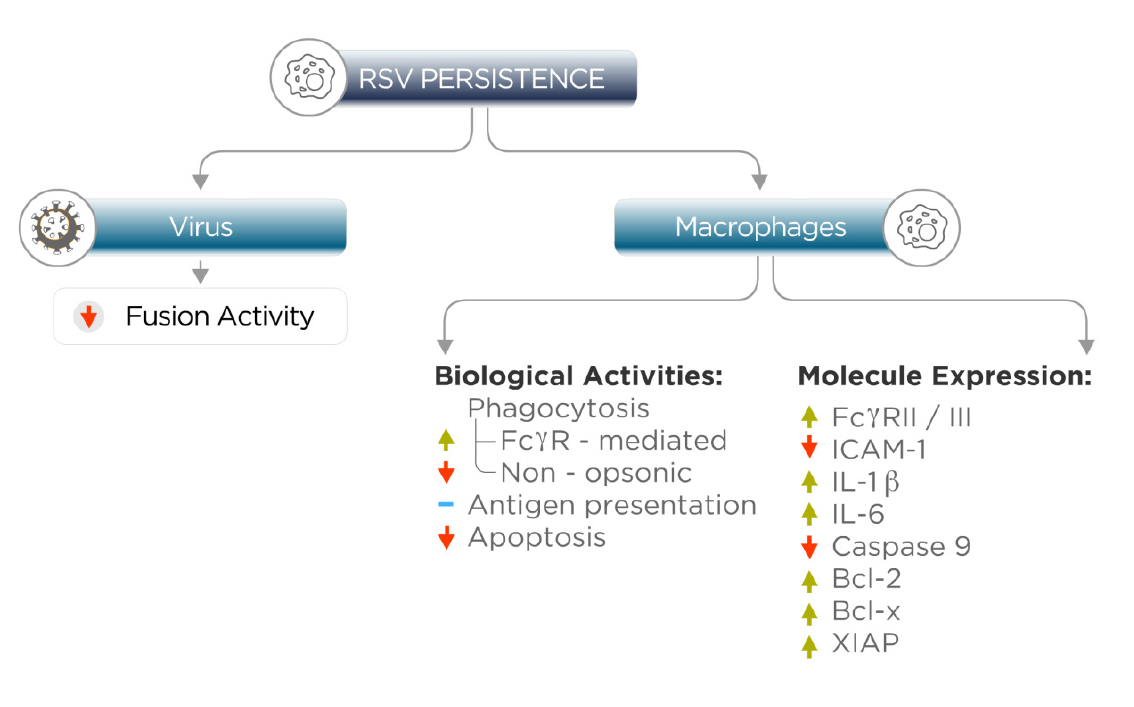
Figure 1. Changes in respiratory syncytial virus (RSV) and macrophages by persistent infection. RSV persistence in macrophages leads to genotypic changes, at least in the viral membrane fusion protein F and in the profile of cellular gene expression. Arrows indicate increase or decrease in biological activities or molecule